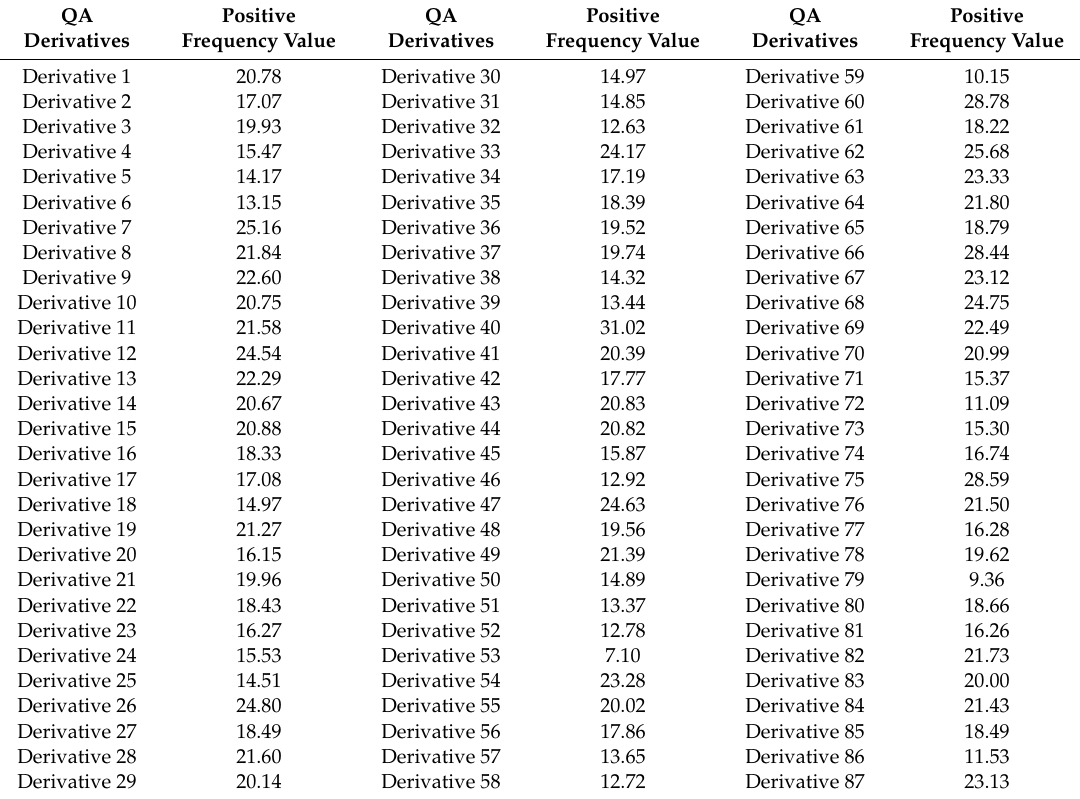
Table 8. The results of positive frequency values of 87 QAs